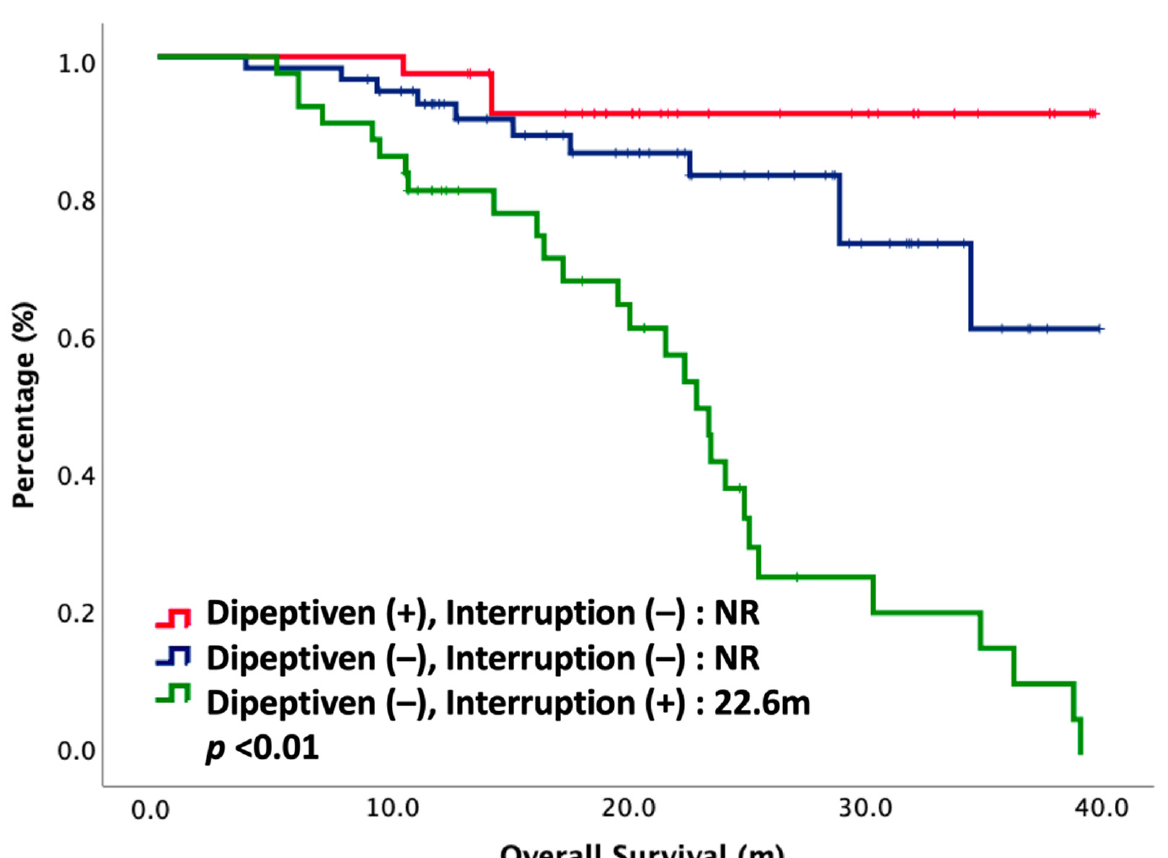
Figure 2. Overall survival of 144 NPC patients treated with CCRT, stratified by dipeptiven and CCRT interruption. NR, not reached.